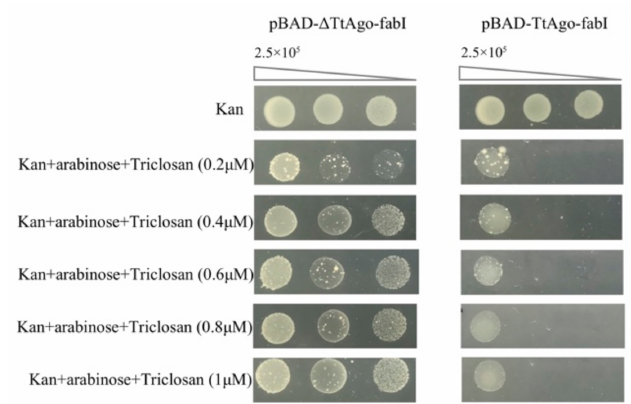
Figure 7. Spot plating assay for optimizing concentration of chemical triclosan. pET28a- ∆ TtAgo-fabI plasmid encoding a truncated TtAgo with a large in-frame deletion was used as a loss-of-function control for enzymatic dead TtAgo activity. Two biological replicates each for pET28a-pBAD- ∆ TtAgo- fabI and pET28a- pBAD-TtAgo-fabI were performed for each